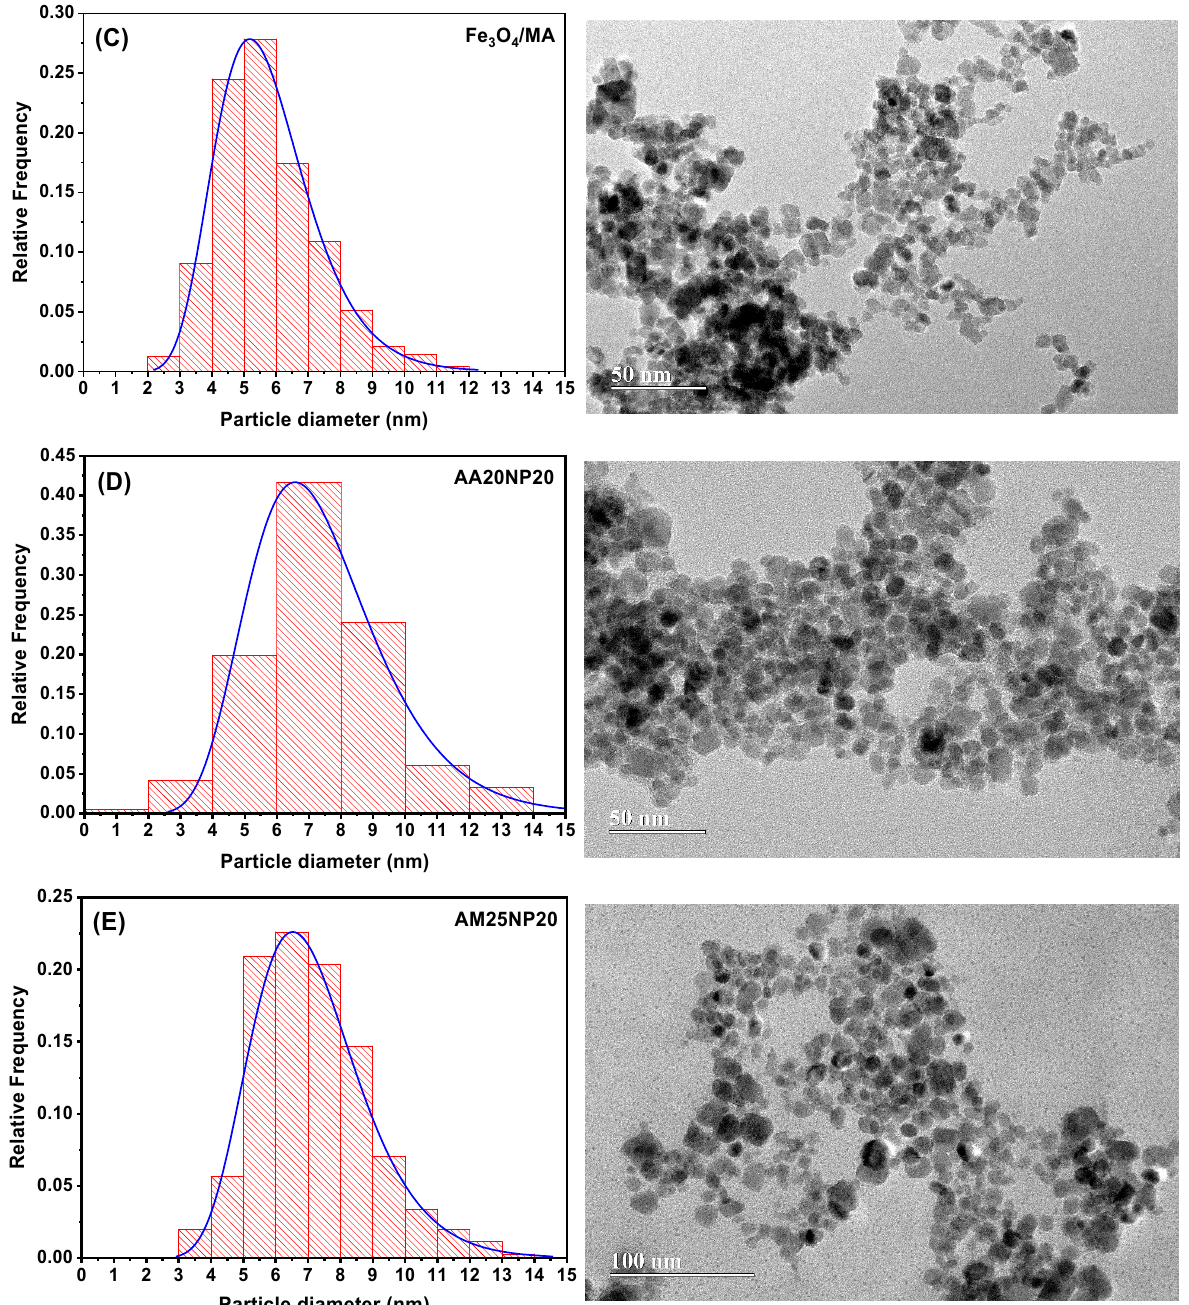
Figure 2. Histograms of the particle size distribution of Fe 3 O 4 magnetic nanoparticles and micrographs of TEM analysis: ( A ) non-modified Fe 3 O 4 ; ( B ) surface-modified Fe 3 O 4 with acrylic acid; ( C ) surface-modified Fe 3 O 4 with methacrylic acid; ( D ) magnetic poly(vinyl pivalate) containing Fe 3 O 4 modified with acrylic acid (AA20NP20); ( E ) magnetic poly(vinyl pivalate) containing Fe 3 O 4 modified with methacrylic acid (AM25NP20). The continuous blue line refers to lognormal distribution. The smaller values of D TEM determined for Fe 3 O 4 modified with carboxylic